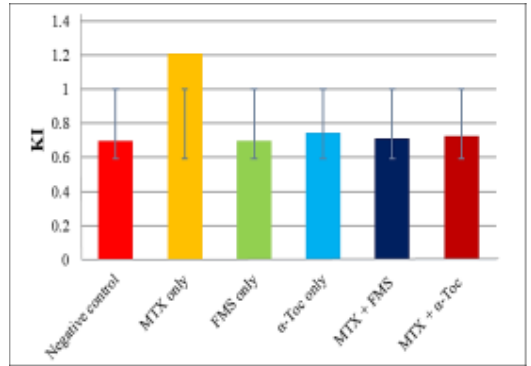
Figure 5.Effects of fimasartan on the kidney index